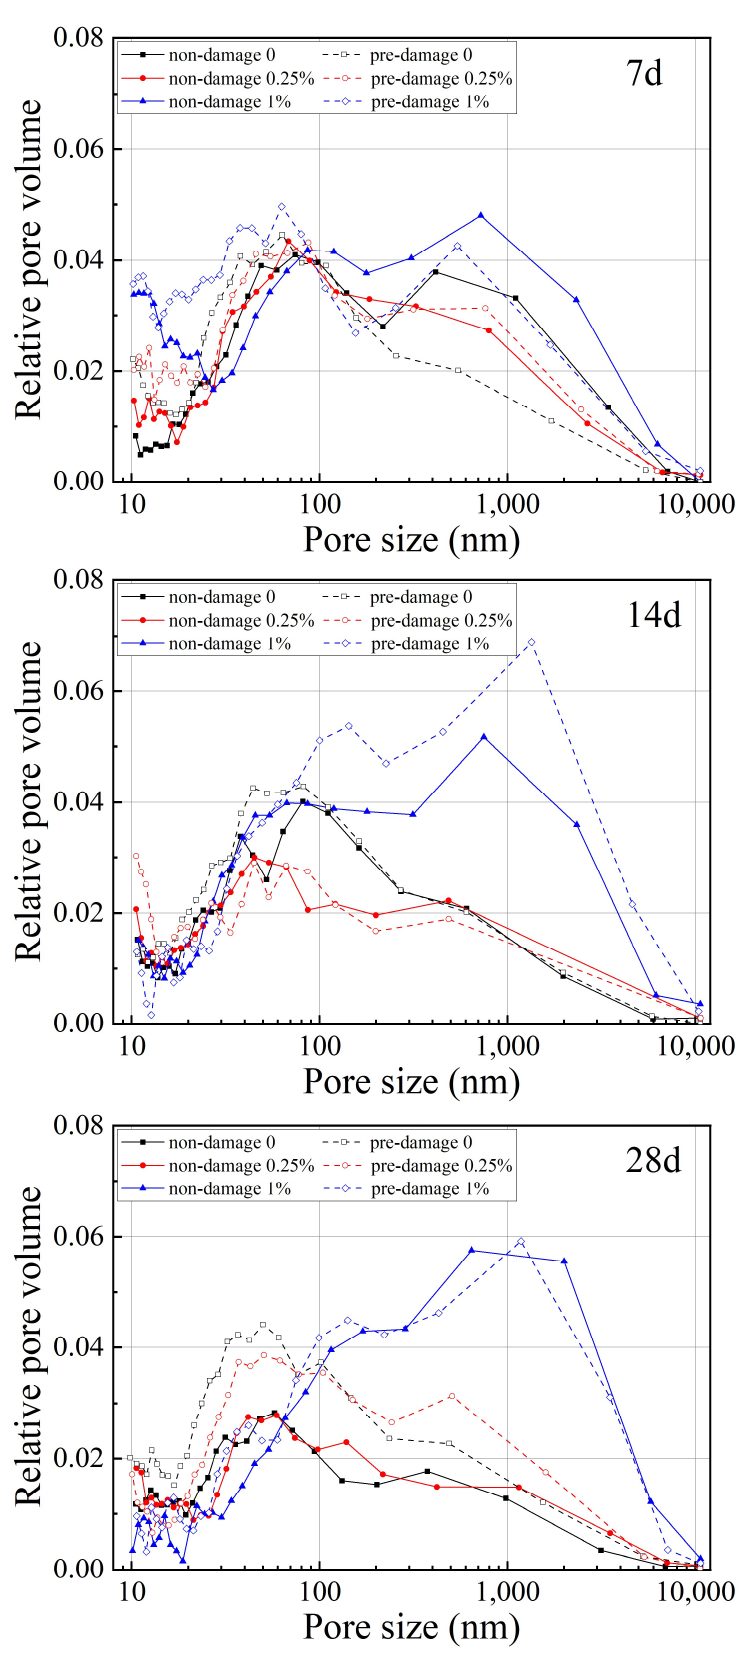
Figure 6. The relative pore volume of samples in non-damage and pre-damage states at a W/C ratio under 0.35, with different ages (7 d, 14 d, and 28 d) and SAP components (0%, 0.25%, and 1%).